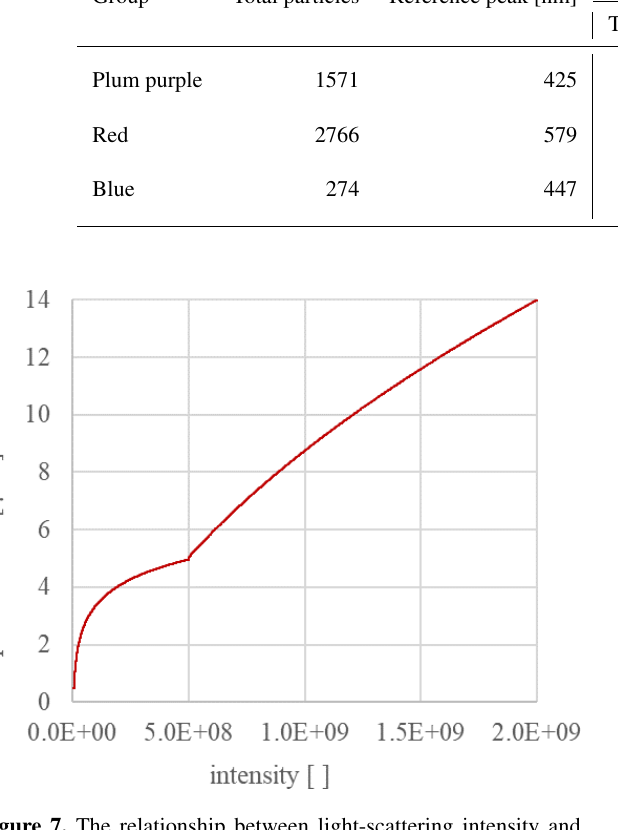
Figure 7. The relationship between light-scattering intensity and particle size for the Plair Rapid-E as recommended by the manufac- turer. Note that two different equations are used to calculate size for particles smaller and larger than 5µm in diameter,